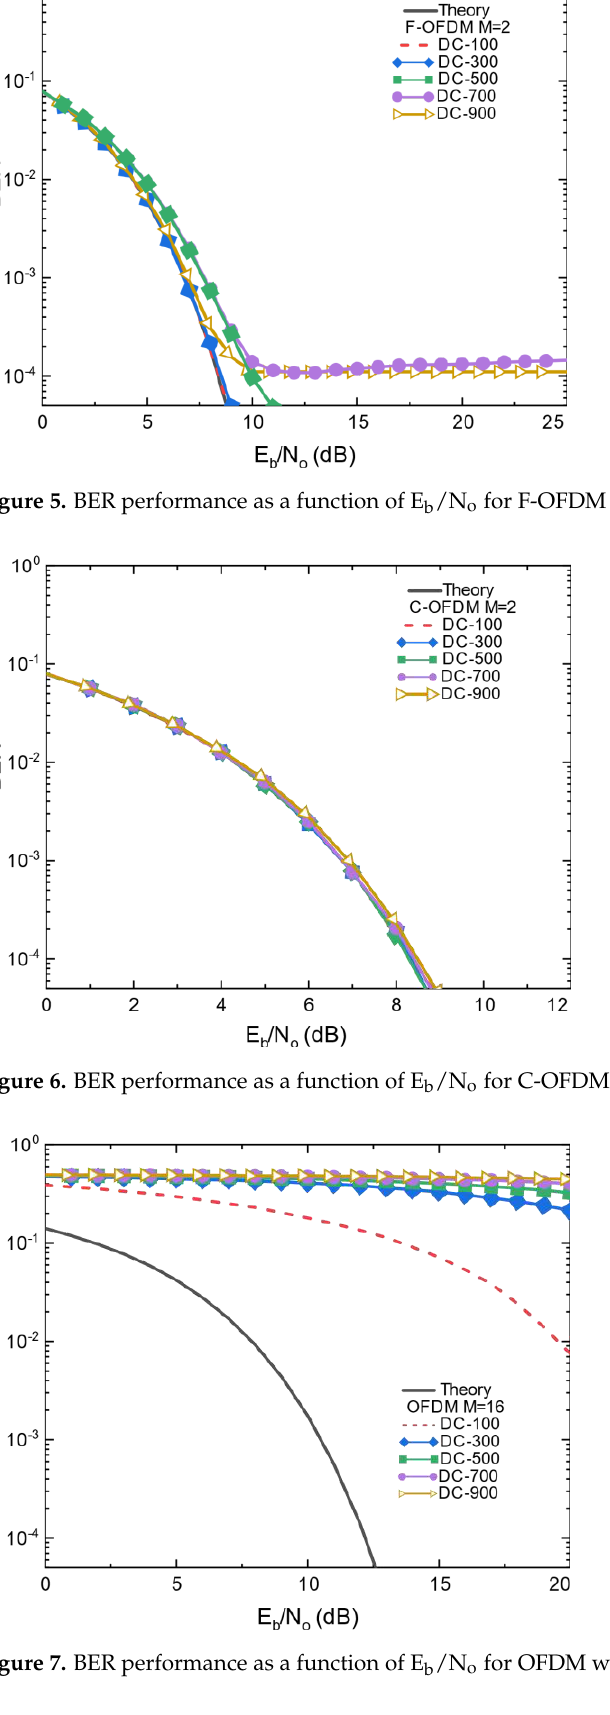
Figure 8. BER performance as a function of E b /N o for F-OFDM with 4-PAM and 200 AC. Moreover, for all the bias points, the C-OFDM’s BER’s performance was better than the conventional OFDM and F-OFDM. Furthermore, Figures 6 and 9 show the BER per- formance of the proposed systems with 2-PAM and 4-PAM, respectively, where both showed an improved BER performance in contrast to the typical OFDM and F-OFDM. Finally, we changed the AC level to 600 mA, as seen in Figures 10–12, for OFDM, F-OFDM and C-OFDM, respectively. It can be seen from Figures 10 and 12 that an ~10 dB improve- ment was achieved at the first bias point compared to conventional OFDM and C-OFDM. At DC bias 300 and 500, an improvement of ~4 dB and 9 dB was achieved when compared between C-OFDM and F-OFDM, respectively, in Figures 11 and 12. However, the BER did not reach the target using F-OFDM with the 600 DC level and an ac bias point greater than 500 mA.